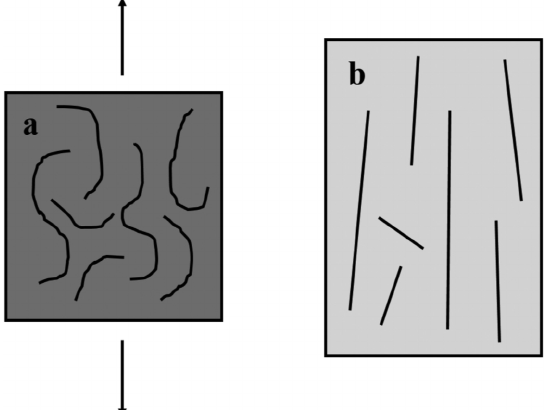
Figure 7. ( a ) Composite sample with coiled MWCNTs before stretching; ( b ) Stretched sample with straight MWCNTs. Reproduced with permission from [69], Copyright Elsevier, 2015.